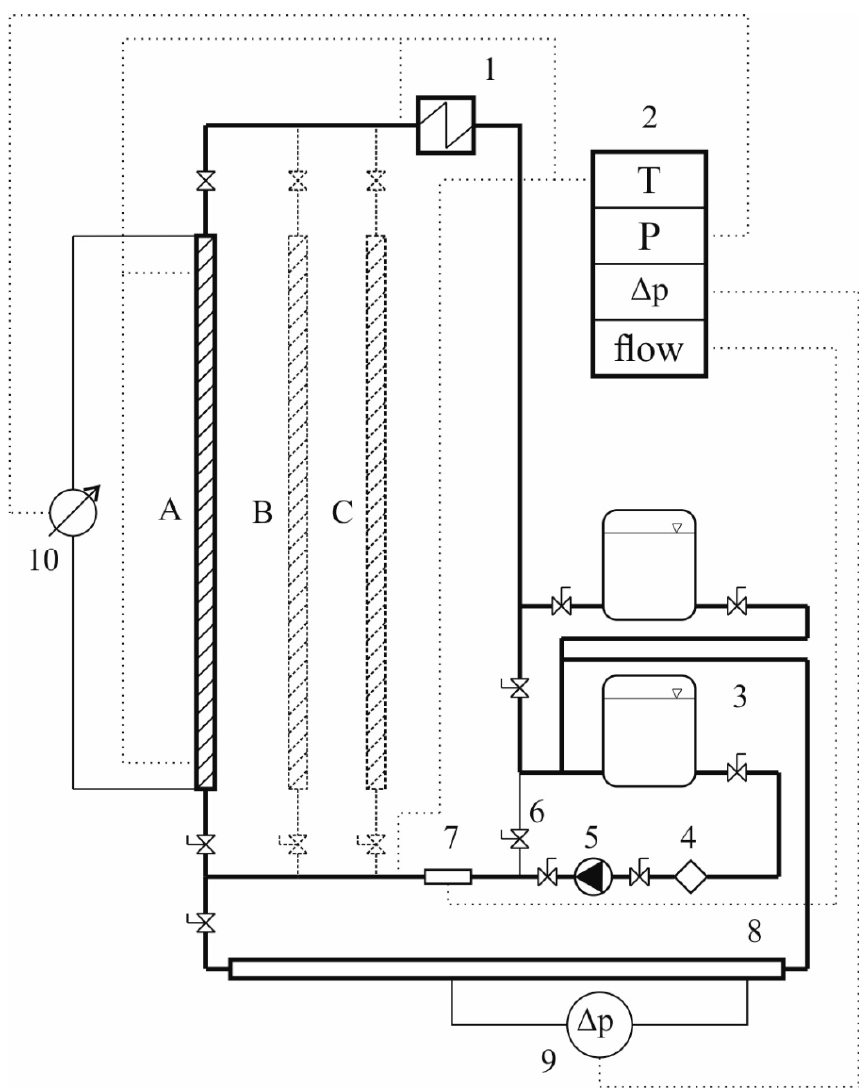
Figure 3. Diagram of the test stand. A—rifled tube (to determine the heat transfer coe ffi cient); B, C —other tested objects; 1—cooler; 2—data acquisition system; 3—circulating water containers; 4—contamination filter; 5—circulating pump; 6—bypass; 7—flowmeter; 8—horizontal segment for frictional loss testing; 9—di ff erential pressure meter; 10—heating elements power control